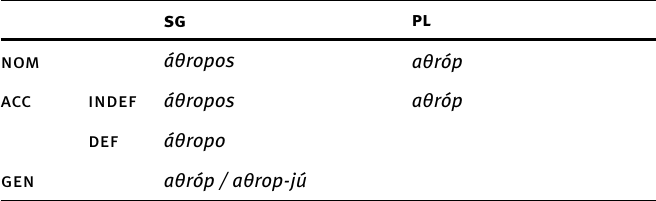
Table 10. Animate declension in Northwest Cappadocian and at Mistí sg pl